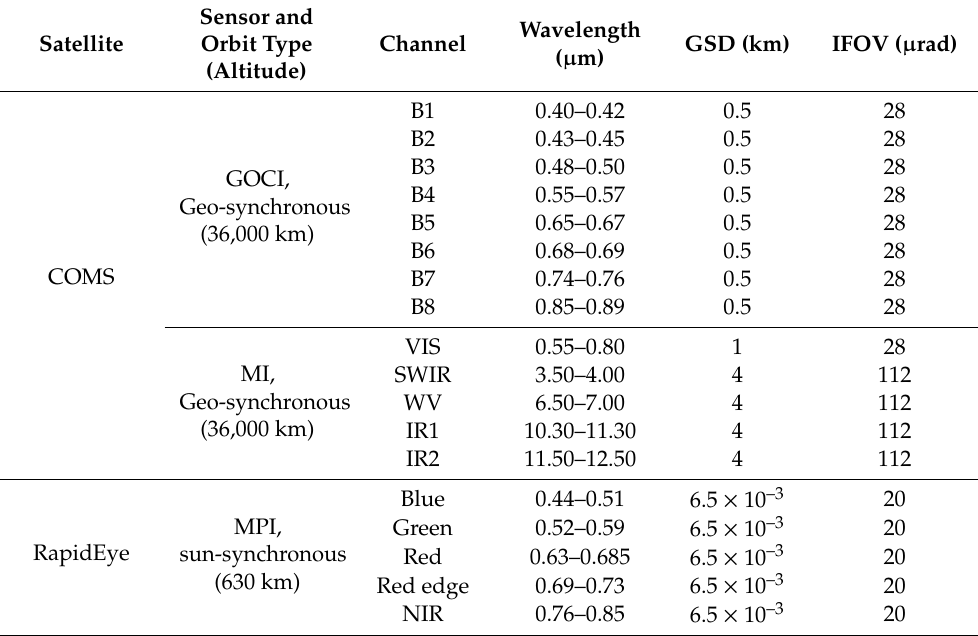
Table 2. Detailed characteristics of the Geostationary Ocean Colour Imager (GOCI) and the Meteorological Imager (MI) sensors of the Communication Ocean and Meteorological Satellite (COMS) as well as the Multispectral Push-broom Imager (MPI) of the RapidEye